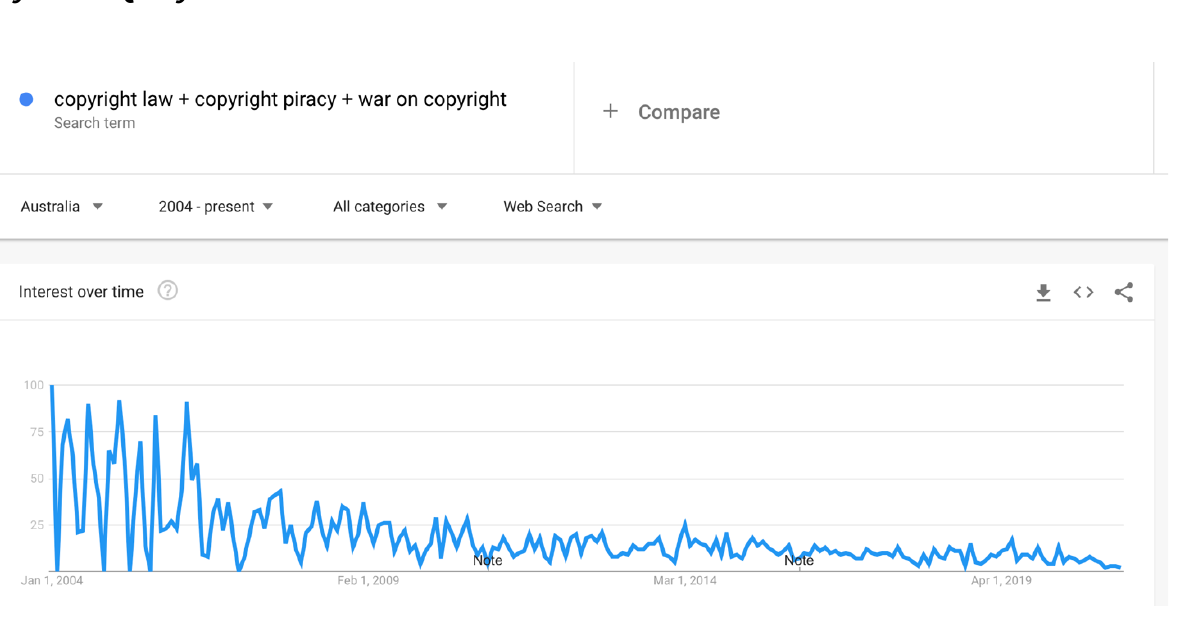
Figure 2: Combined piracy metaphors Search Query Index for ‘copyright law + copyright piracy + war on copyright’ (31 March 2021) Data source: Google Trends